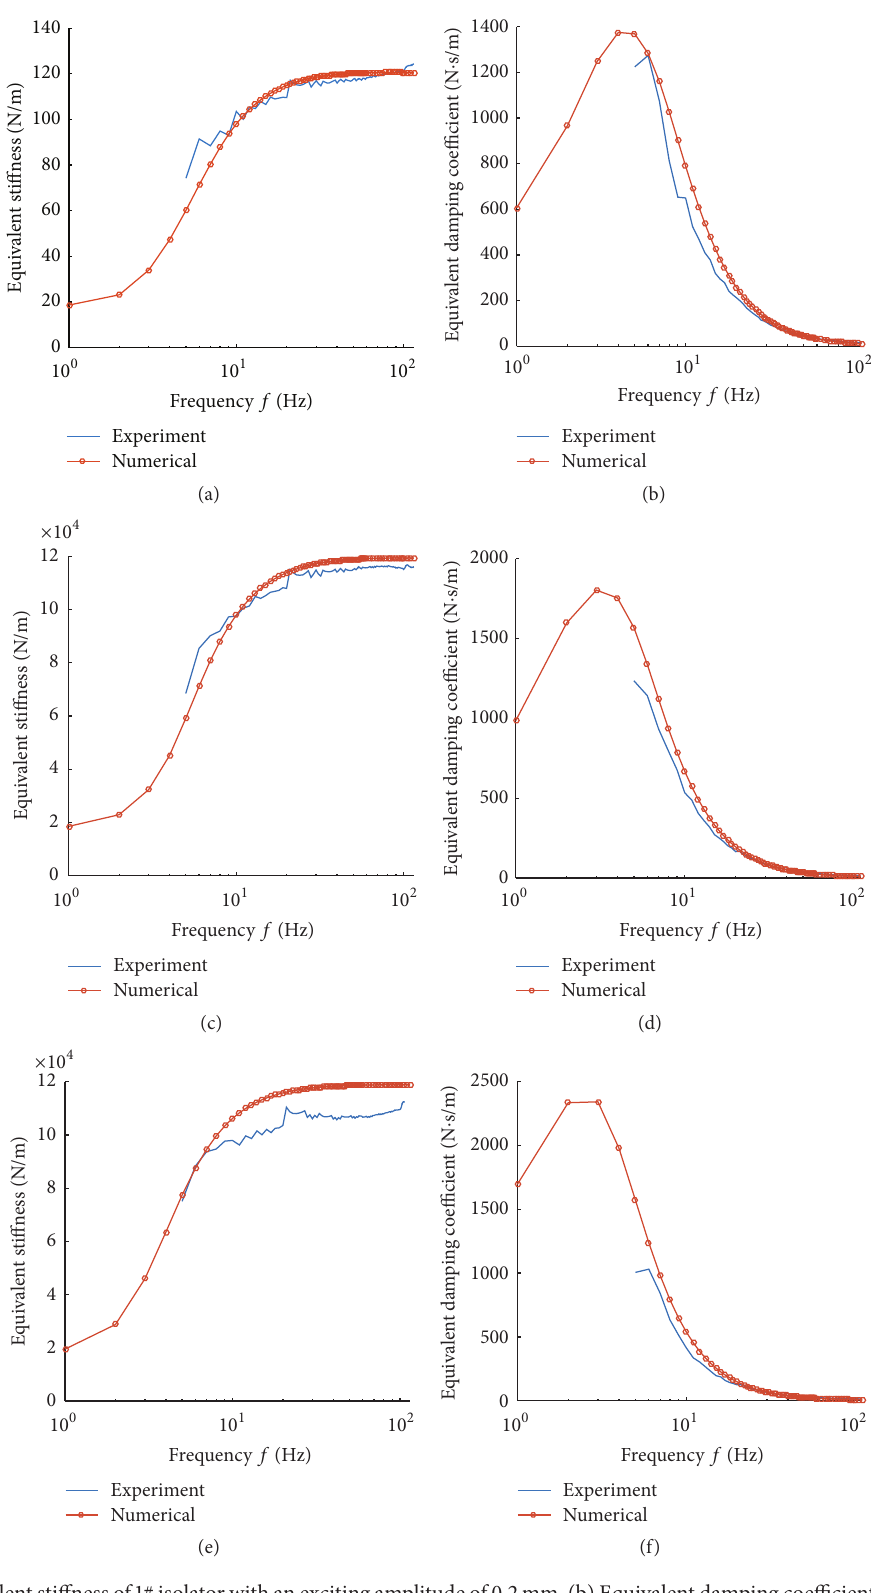
Figure 7: (a) Equivalent stiffness of 1# isolator with an exciting amplitude of 0.2 mm. (b) Equivalent damping coefficient of 1# isolator with an exciting amplitude of 0.2mm. (c) Equivalent stiffness of 1# isolator with an exciting amplitude of 0.4 mm. (d) Equivalent damping coefficient of 1# isolator with an exciting amplitude of 0.4 mm. (e) Equivalent stiffness of 1# isolator with an exciting amplitude of 0.8 mm. (f) Equivalent damping coefficient of 1# isolator with an exciting amplitude of